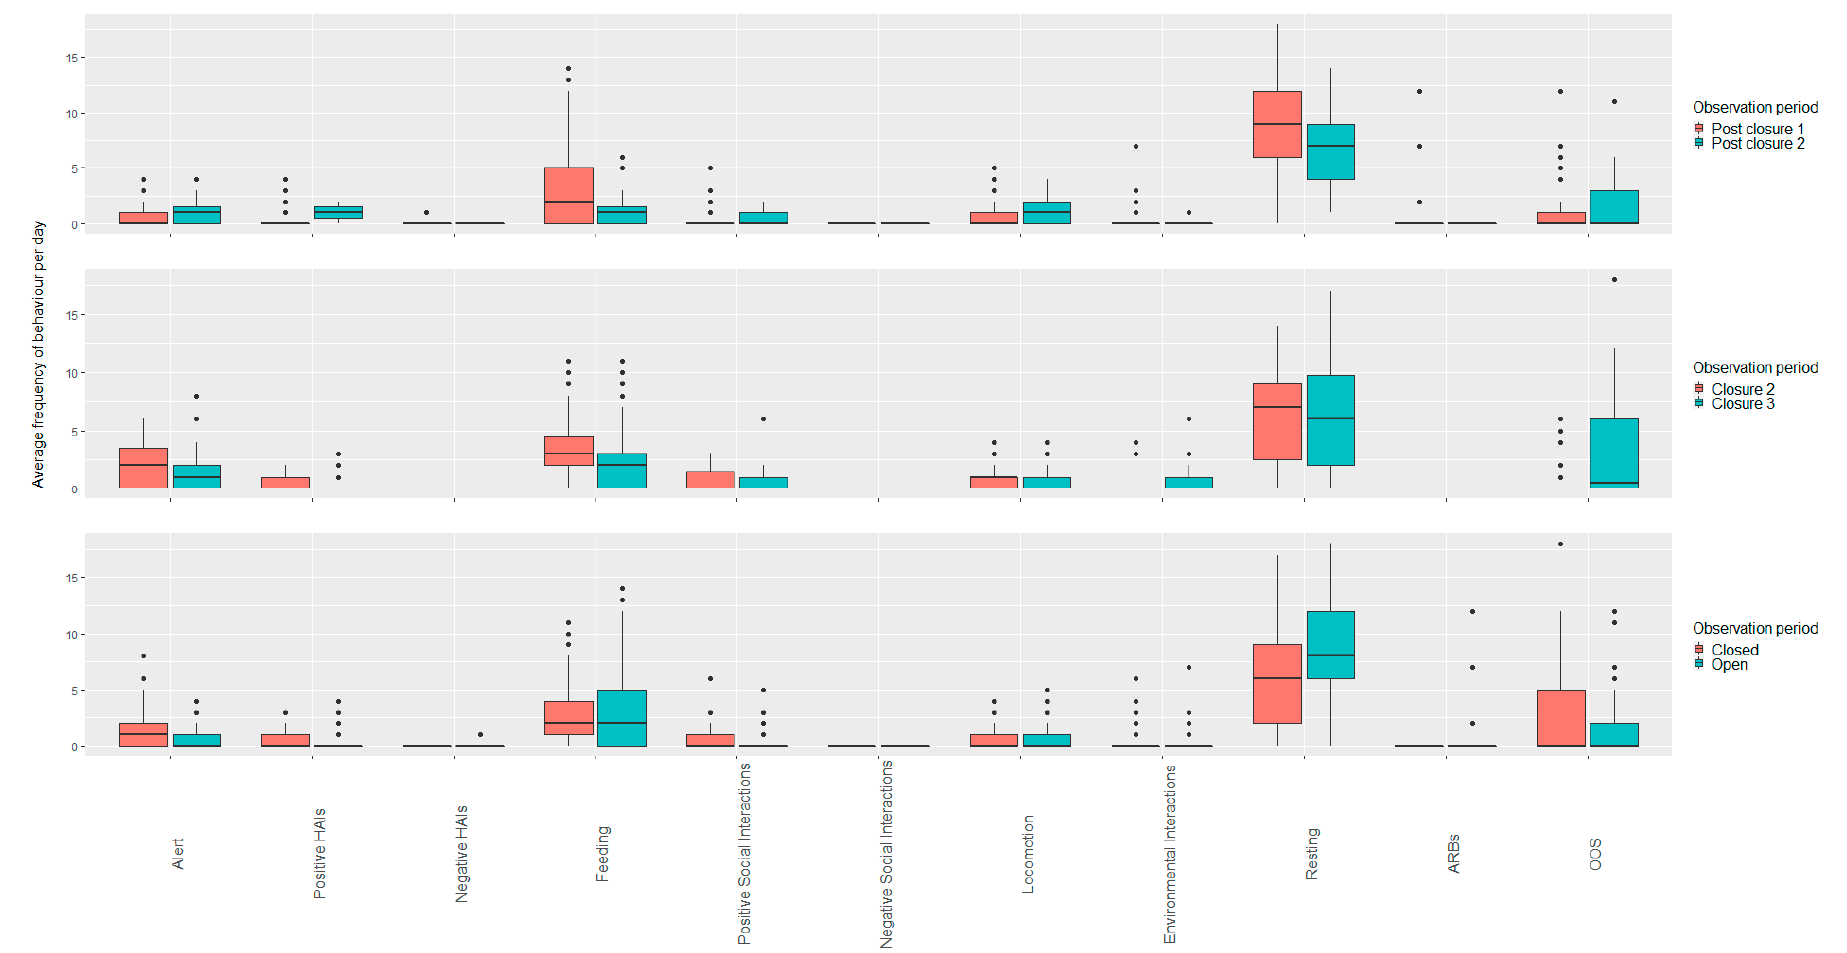
Figure 3. An overview of activity of rabbits housed at White Post Farm throughout the closure and reopening periods. Dots represent outliers.